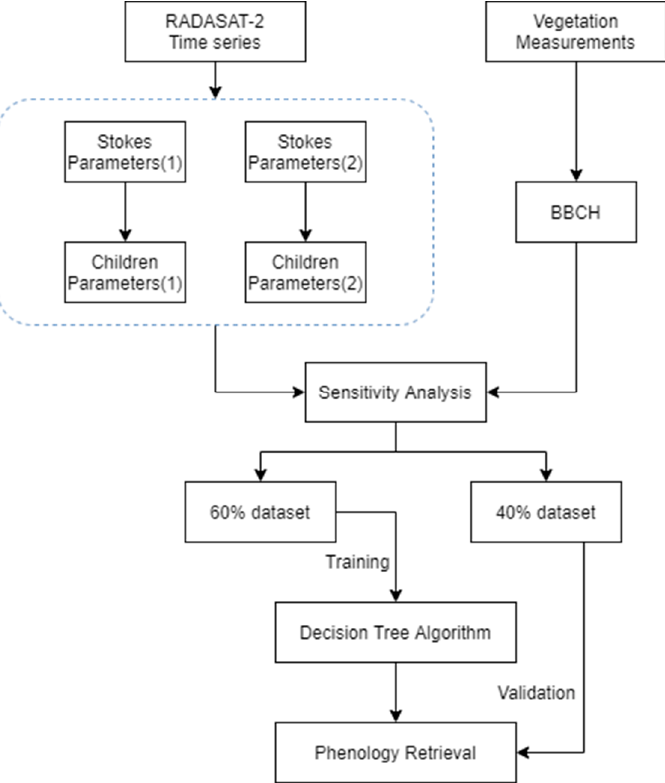
Figure 3. Flowchart of oilseed rape phenology retrieval from RADARSAT-2 multi-temporal data and DT algorithm.